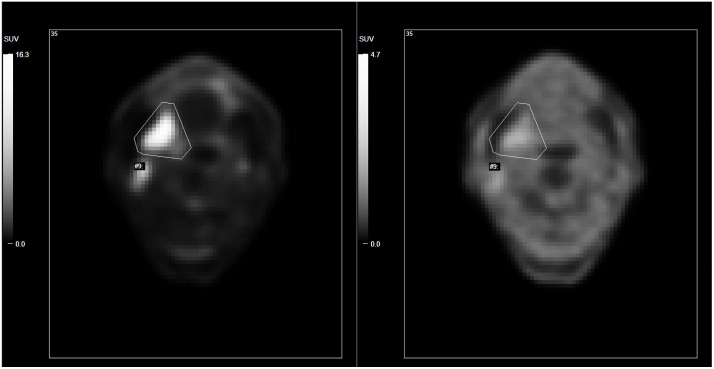
Side by side comparison of FDG (left) and FMISO (right) PET image of a representative patient with a SCC on the right side surrounded by the manual ROI.Note: different contrast ratio selected for each PET image.